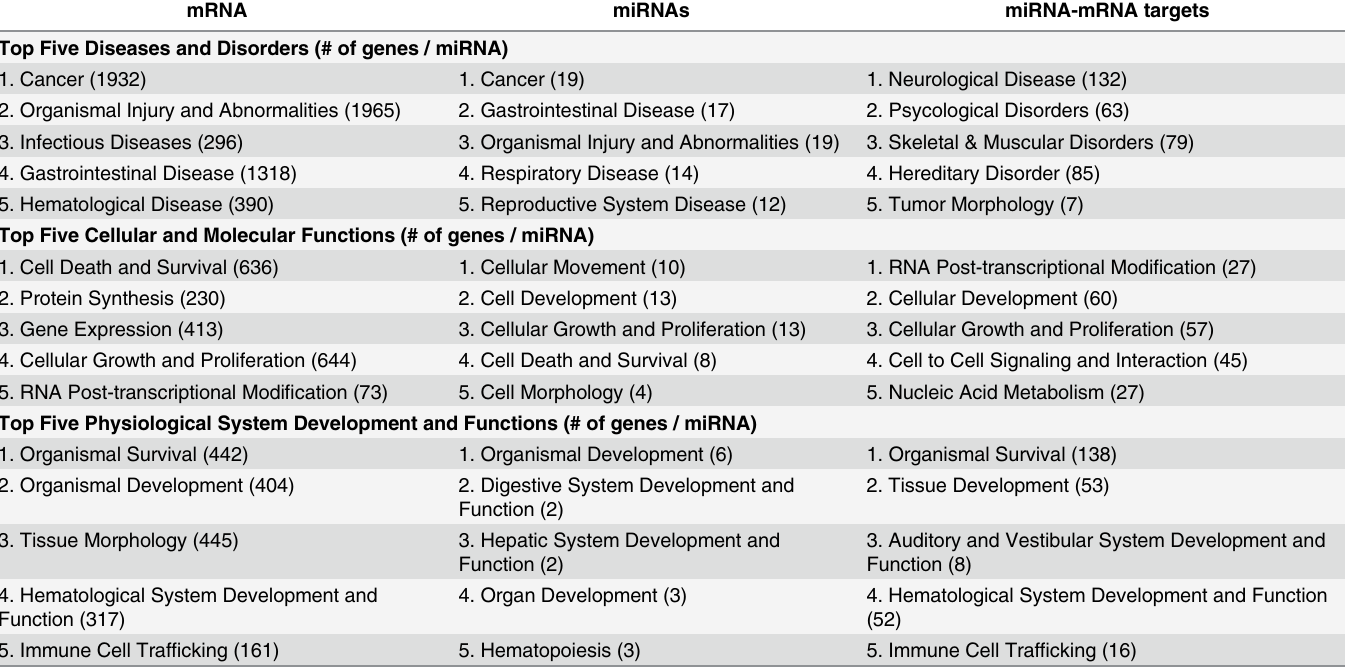
Table 4. Functional analysis of differentially expressed mRNAs, miRNAs and miRNA-mRNA target pairs in the whole blood of workers exposed to MWCNTs. mRNA miRNAs miRNA-mRNA targets Top Five Diseases and Disorders (# of genes /